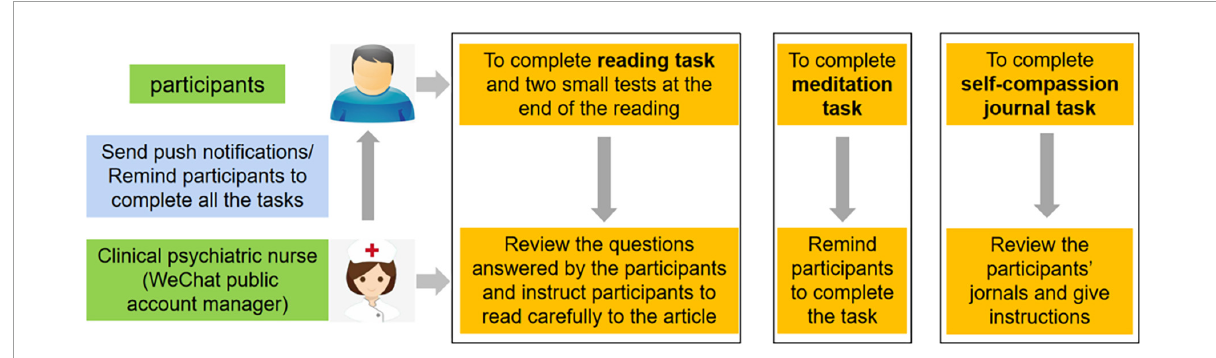
FIGURE2 Function of the ‘Self-compassion Tour’ system. Figure created with Microsoft Office PowerPoint.